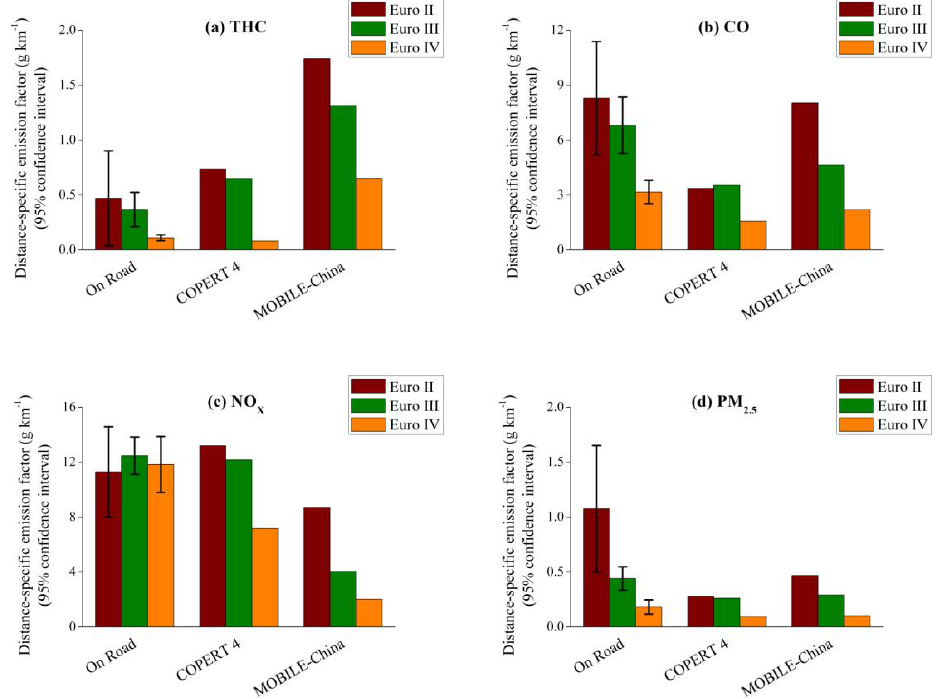
Fig. 3. Emission factors of (a) THC, (b) CO, (c) NO x and (d) PM 2 . 5 for Euro II, Euro III and Euro IV diesel buses under a typical urban driving cycle with an average speed of 18kmh − 1 .